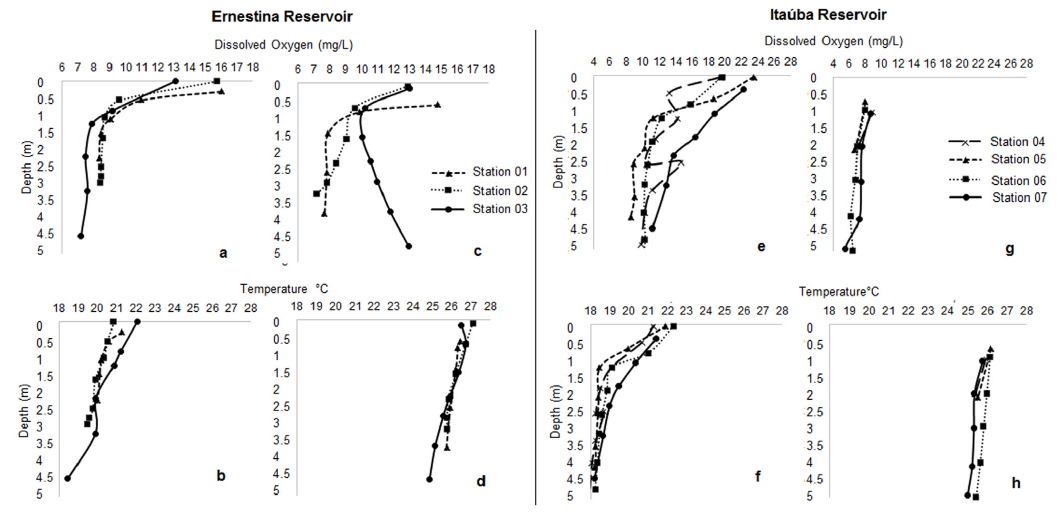
Figure 4. Dissolved oxygen and water temperature vertical profiles in Ernestina in September 2012 (a and b) and January 2013 (c and d) and Itaúba in August 2012 (e and f) and February 2013 (g and